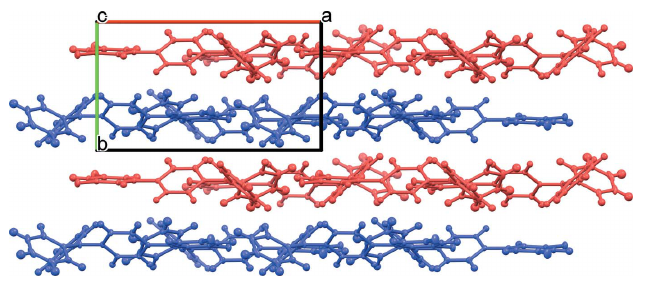
Figure 3 Crystal packing of the title compound viewed along [001]. Alternating layers are highlighted in blue and red.